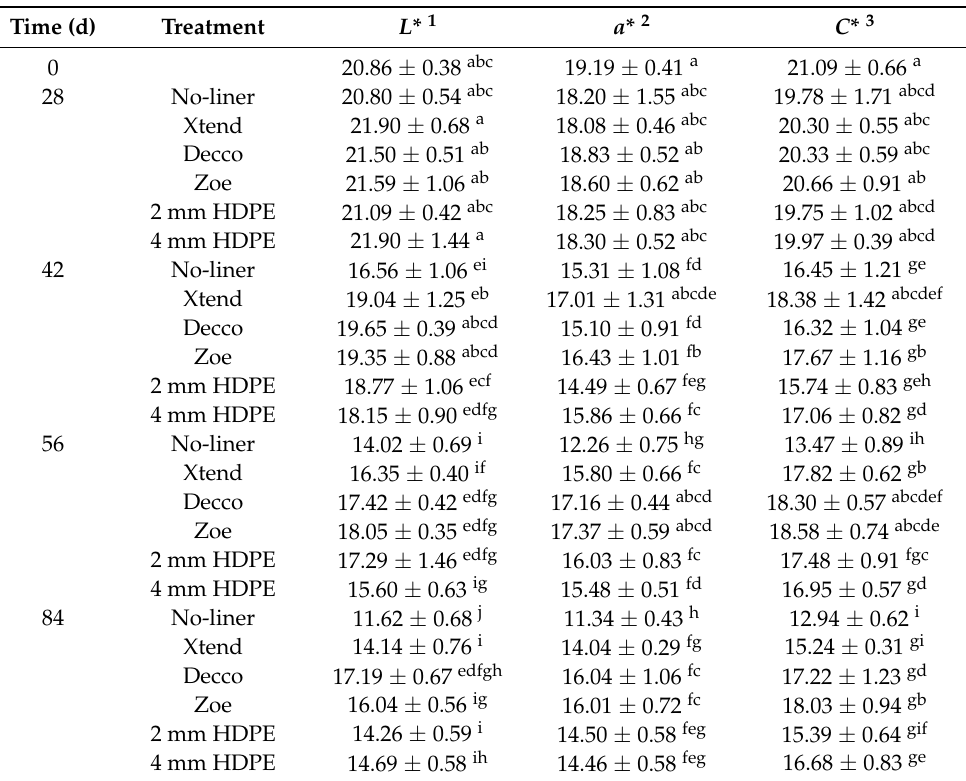
Table 6. Impact of liner treatment on pomegranate aril colour parameters. Fruit were stored for 84 d at 5 ◦ C and 90% relative humidity